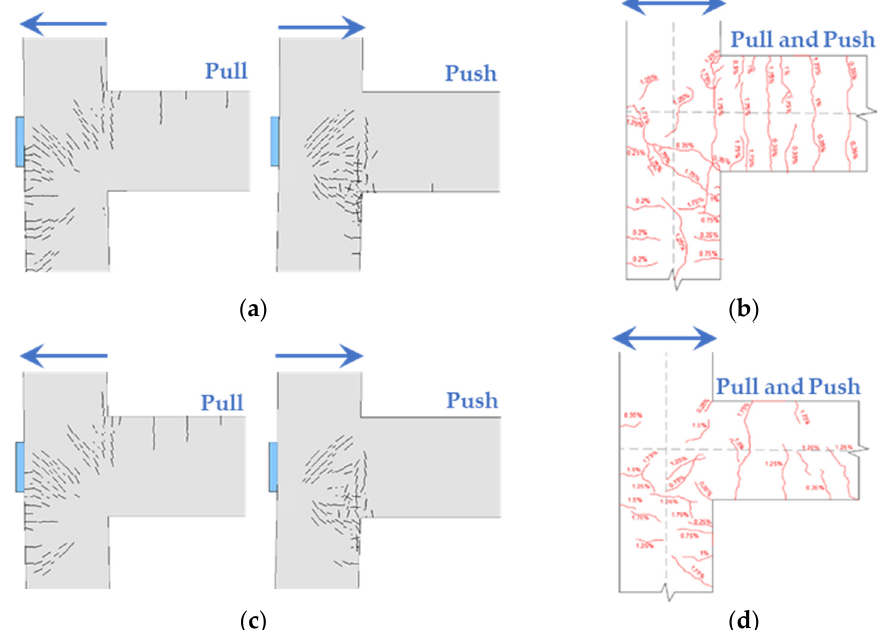
Figure 13. Crack patterns of frames at drift ratio of 1.75%: ( a ) HI-C25 model; ( b ) tested HD frame; ( c ) LI-C25 model; ( d ) tested LD frame.